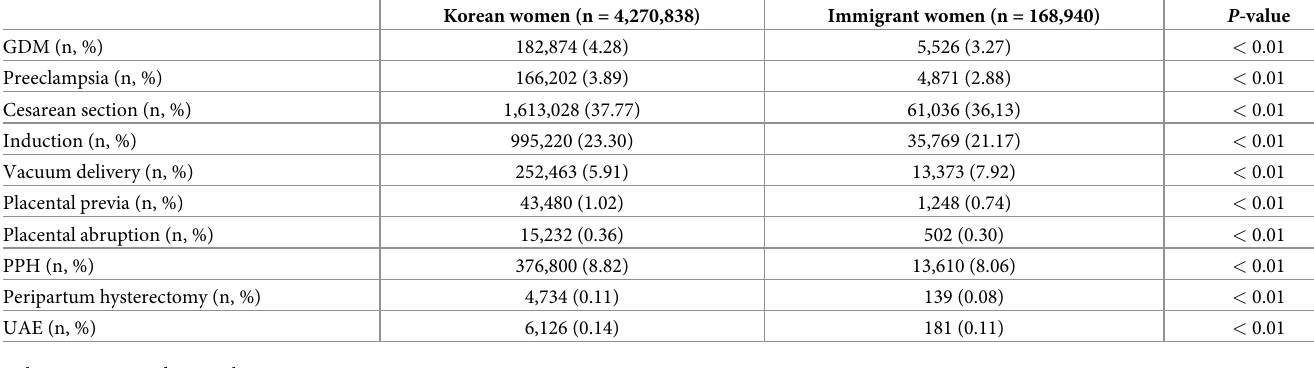
Table 2. The pregnancy outcomes of the study population.